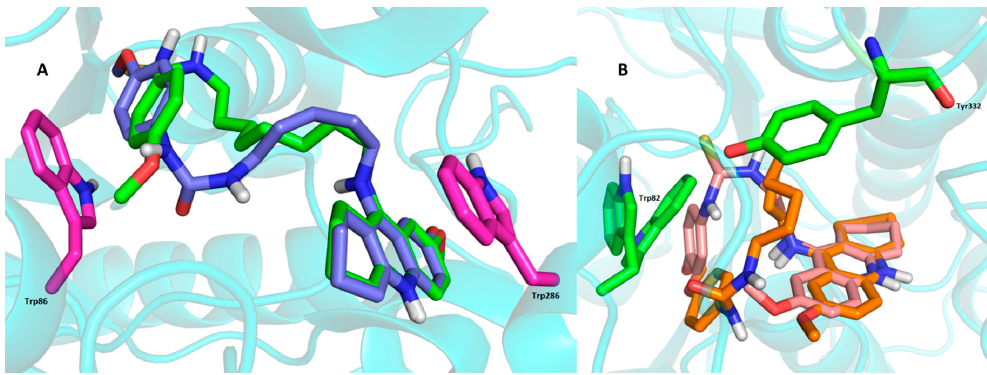
Figure 5 . ( A )—Overlay of the two most populated clusters for 15 (green carbon atoms) and 19 (blue carbon atoms) in the h AChE active site. Trp residues representing CAS (Trp86) and PAS (Trp286) of the enzyme are displayed in magenta; ( B )—Overlay of the two most populated clusters for 9 (salmon pink carbon atoms) and 22 (orange carbon atoms) in the h BChE. Trp82 indicates CAS, Tyr332 designates PAS of the h BChE. Figure was generated using PyMol 1.5.0.4 (The PyMOL Molecular Graphics System, Version 1.5.0.4 Schrödinger,